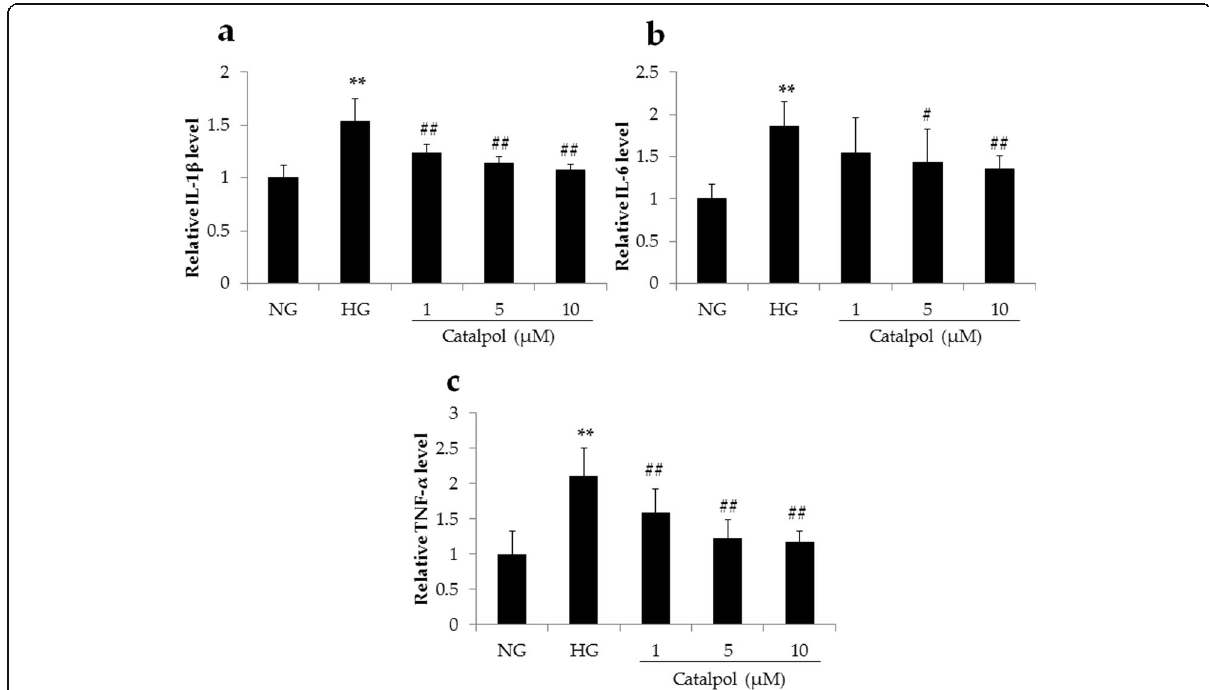
Fig. 5 The anti-inflammatory effect of catalpol on HG-induced podocyte injury. a Relative level of IL-1 β ( n = 6). b Relative level of IL-6 ( n = 6). c Relative level of TNF- α ( n = 6). Data are presented as the mean ± SD. ** p < 0.01 vs NG, # p < 0.05, ## p < 0.01 vs HG